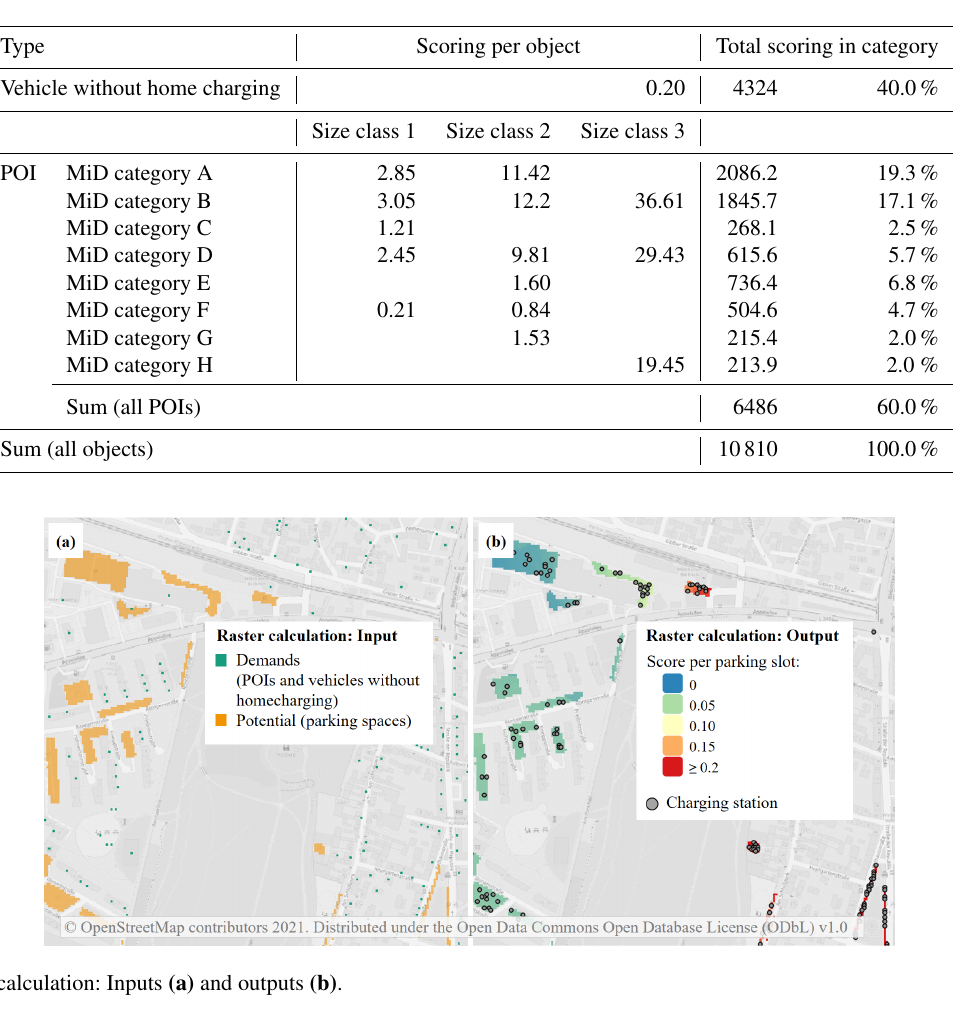
Table 3. Results: Scoring.